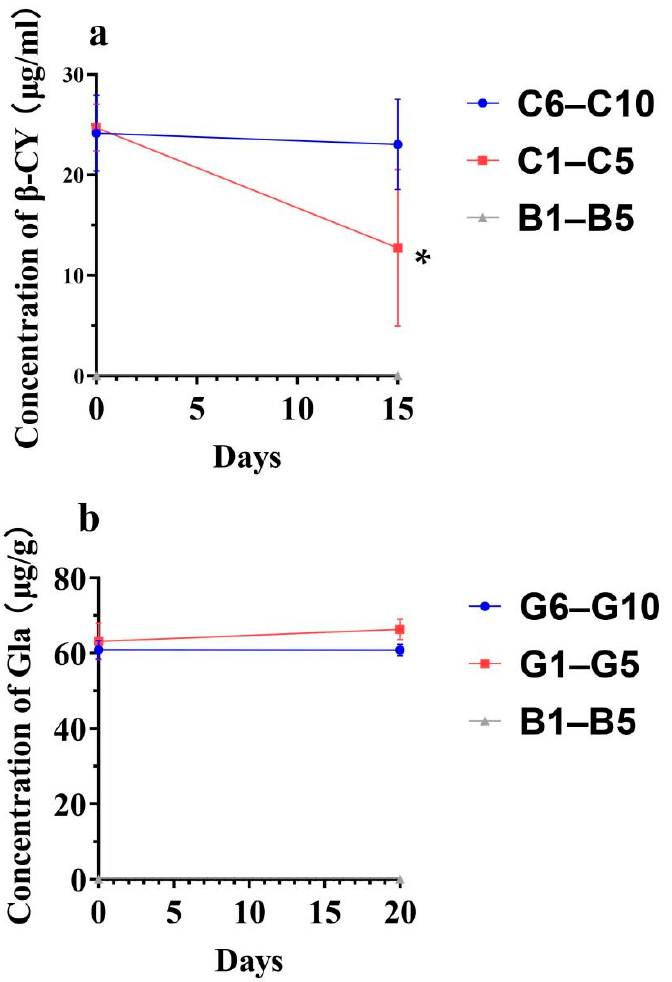
Figure 5. Beta-cypermethrin and glufosinate ammonium fates in MEB media in 250 mL flasks inoculated with Agaricus subrufescens fungal plugs. ( a ), concentration of beta-cypermethrin during the incubation period; ( b ), concentration of glufosinate ammonium during the incubation period; β -CY, beta-cypermethrin; Gla, glufosinate ammonium. B1–B5, 5 repeated flasks with MEB; C1–C5, 5 repeated flasks with MEB, β -CY and A. subrufescens plugs, C6–C10, 5 repeated flasks with MEB and β -CY; G1–G5, 5 repeated flasks with MEB, Gla and A. subrufescens plugs; G6–G10, 5 repeated flasks with MEB and Gla. *, significant difference among different